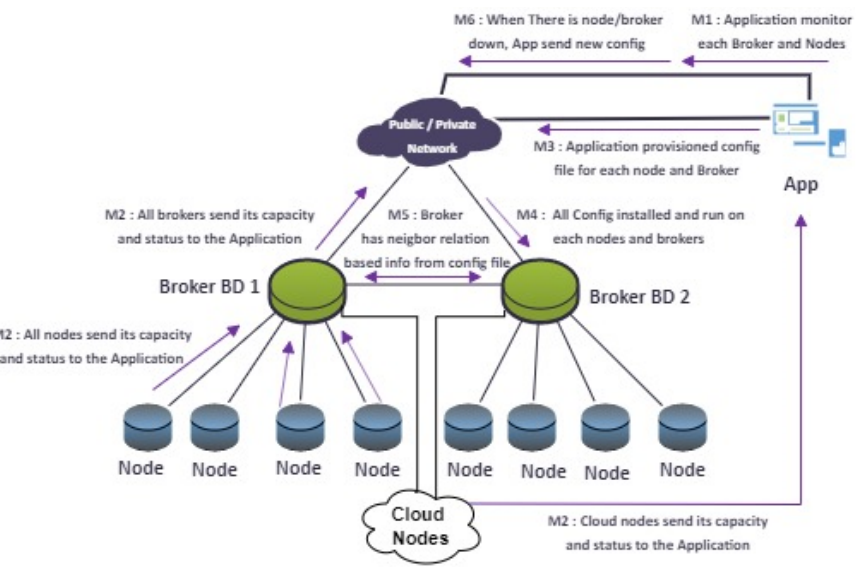
Figure 3. Broadcast domain communication mechanism on lightweight multi-fog topology.